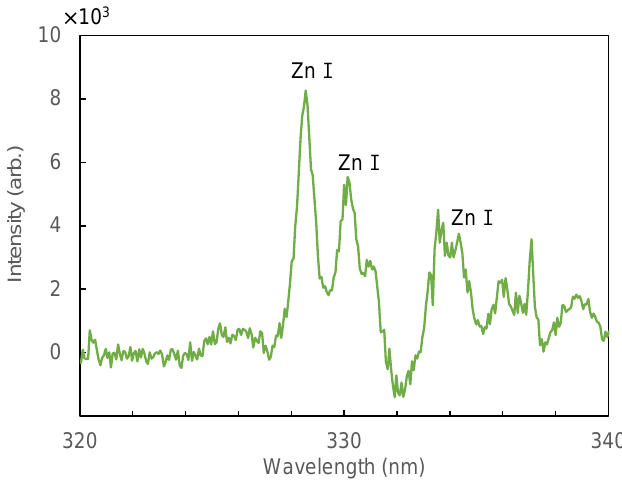
Figure 8. An enlarged LIBS spectrum of hair measured at around 330 nm.